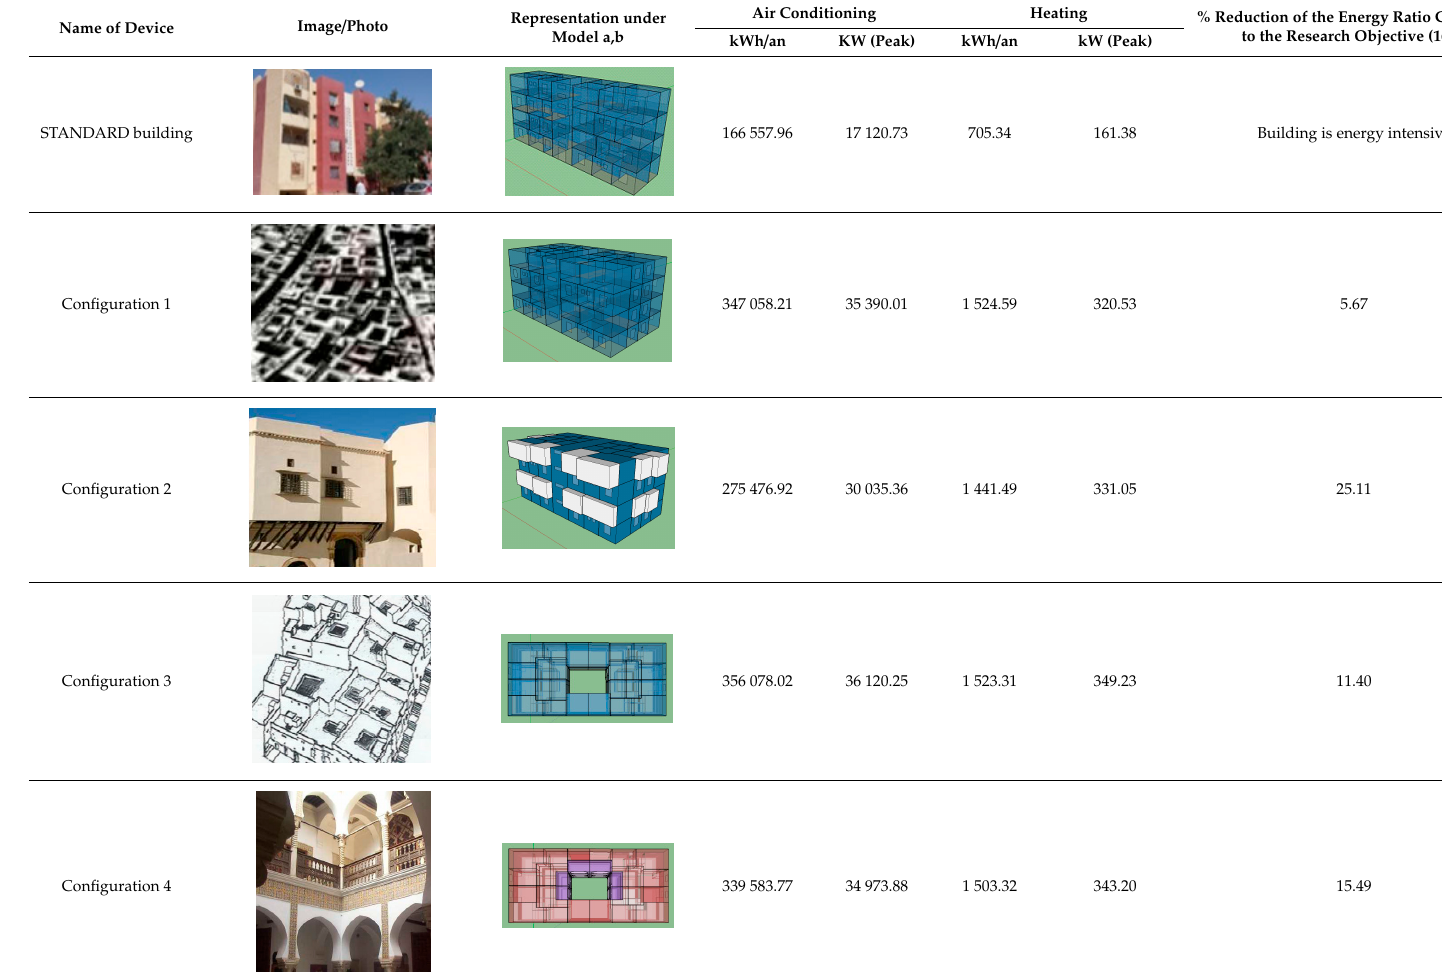
Table 4. Annual Cooling / Heating Loads Results and Reduction Rate Compared to the Reference Building, and Research Objective for Buildings Corresponding to Di ff erent Configurations.